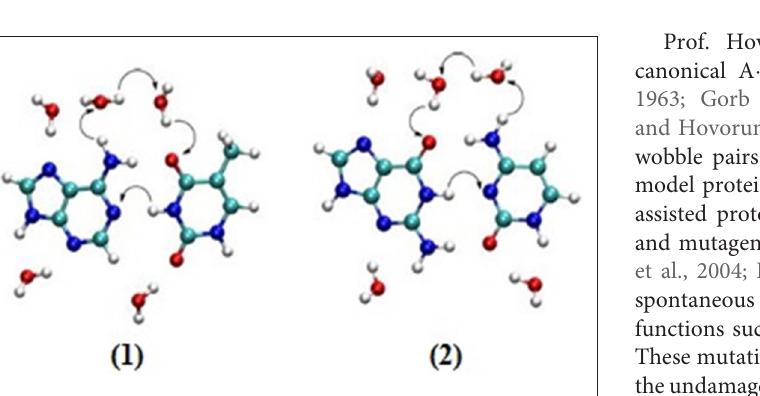
a propeller-like conformation for the studies of single GC base pairs (Floria´n and Leszczy´nski, 1996; Gorb et al., 2004). The PT reaction for GC radical anion (Chen et al., 2009) with hydrated model and stacking effects was carried out with a different level of DFT. Liang and co-workers used the molecular dynamics (MD) method to study the motions of proton (Xiao et al.,